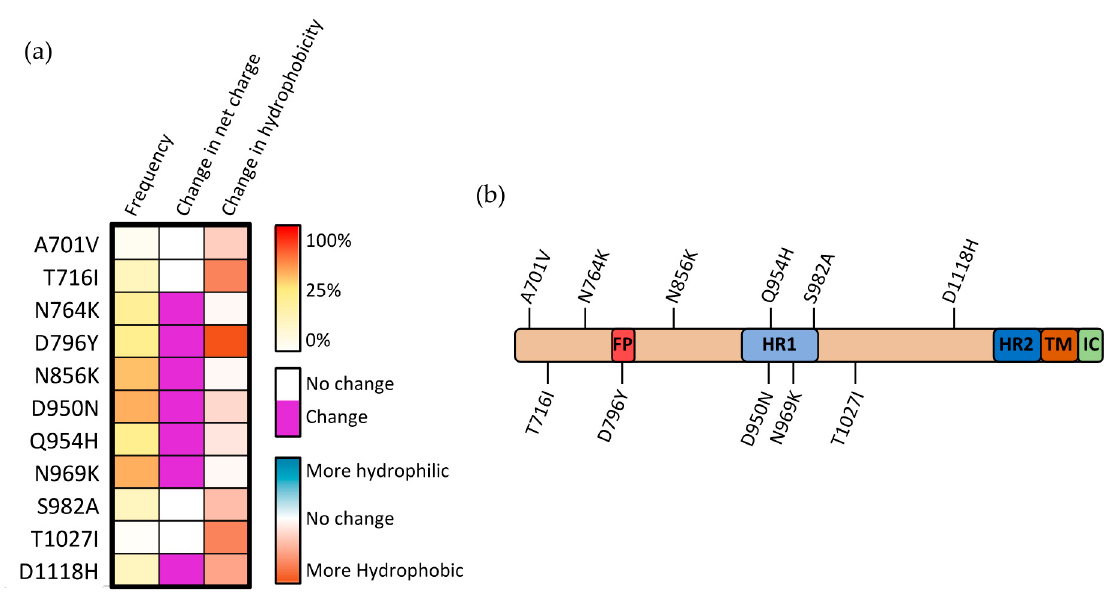
Figure 6. Mutations occurring within the S2 subunit of SARS-CoV-2 spike protein. ( a ) Frequency, modification in charge at physiological pH, and alteration in hydrophobicity for mutations occurring within the S2 subunit. ( b ) Visual representation of mutations occurring within the S2 subunit.